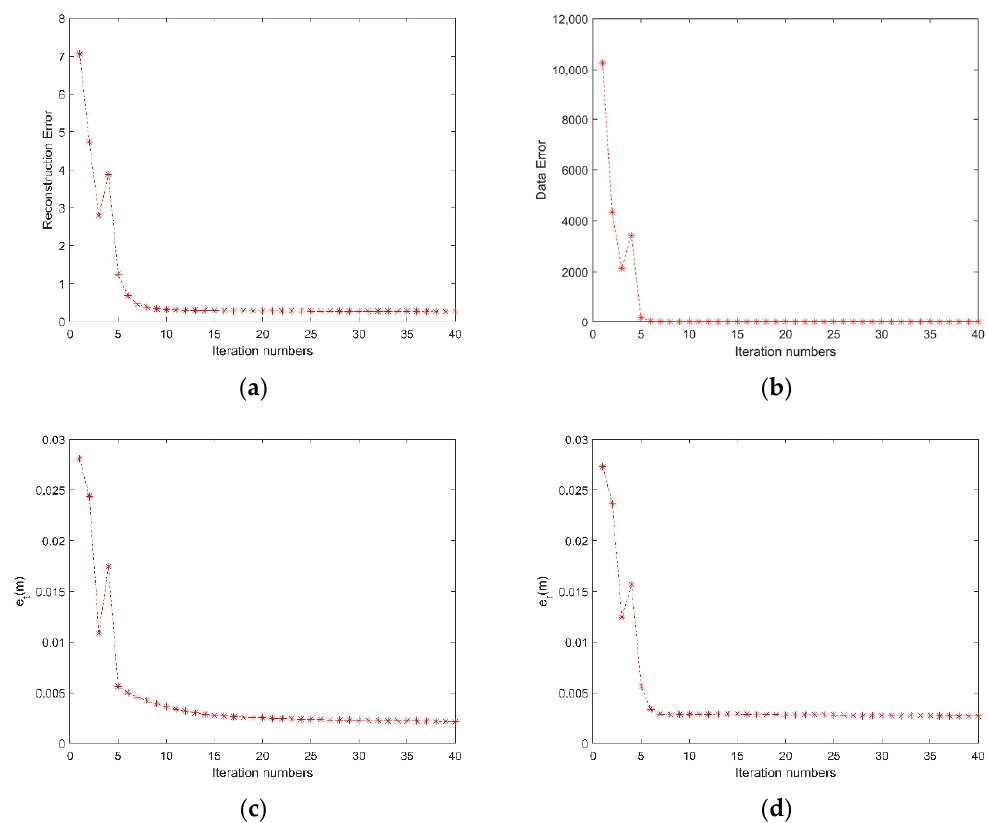
Figure 5. Data error, Reconstruction error, and RMSE of e t and e r across the iteration. ( a ) Data error. ( b ) Reconstruction error. ( c ) RMSE of e t . ( d ) RMSE of e r .